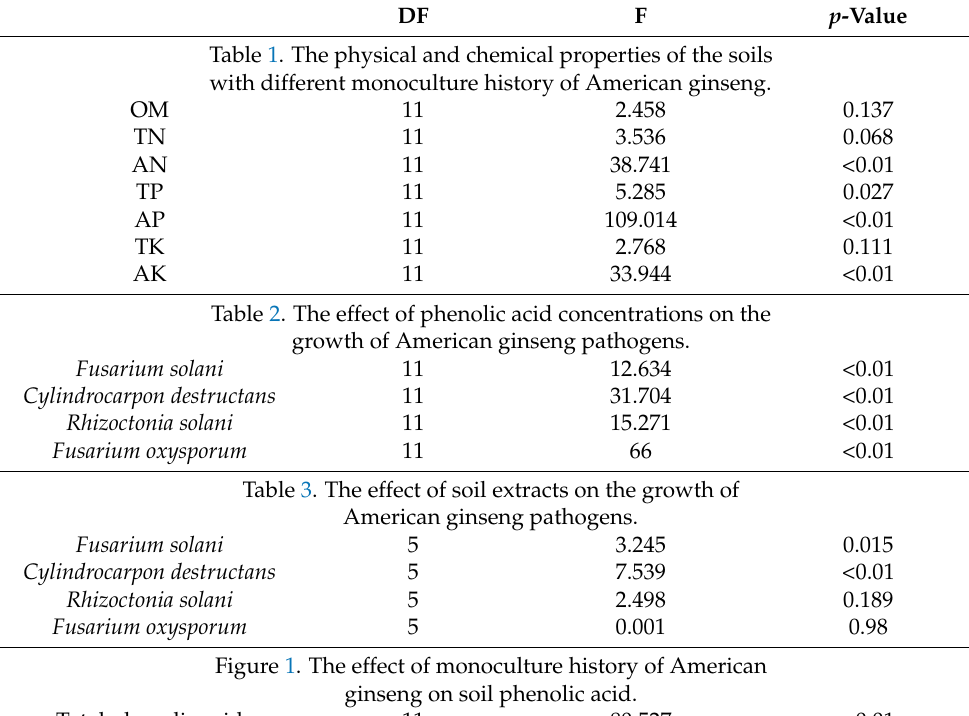
Table A1. The degrees of freedom, F value, and p value for the ANOVA used in the present study. DF F p -Value Table 1. The physical and chemical properties of the soils with different monoculture history of American ginseng.